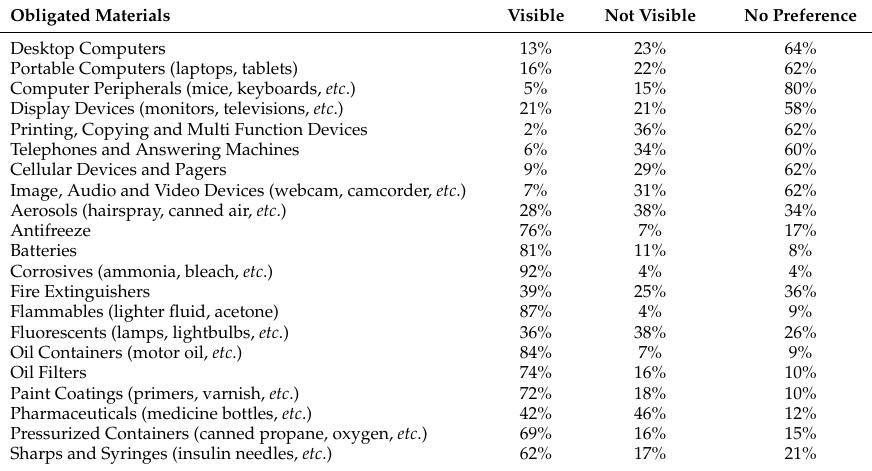
Table 7. Respondent Preference for Fee